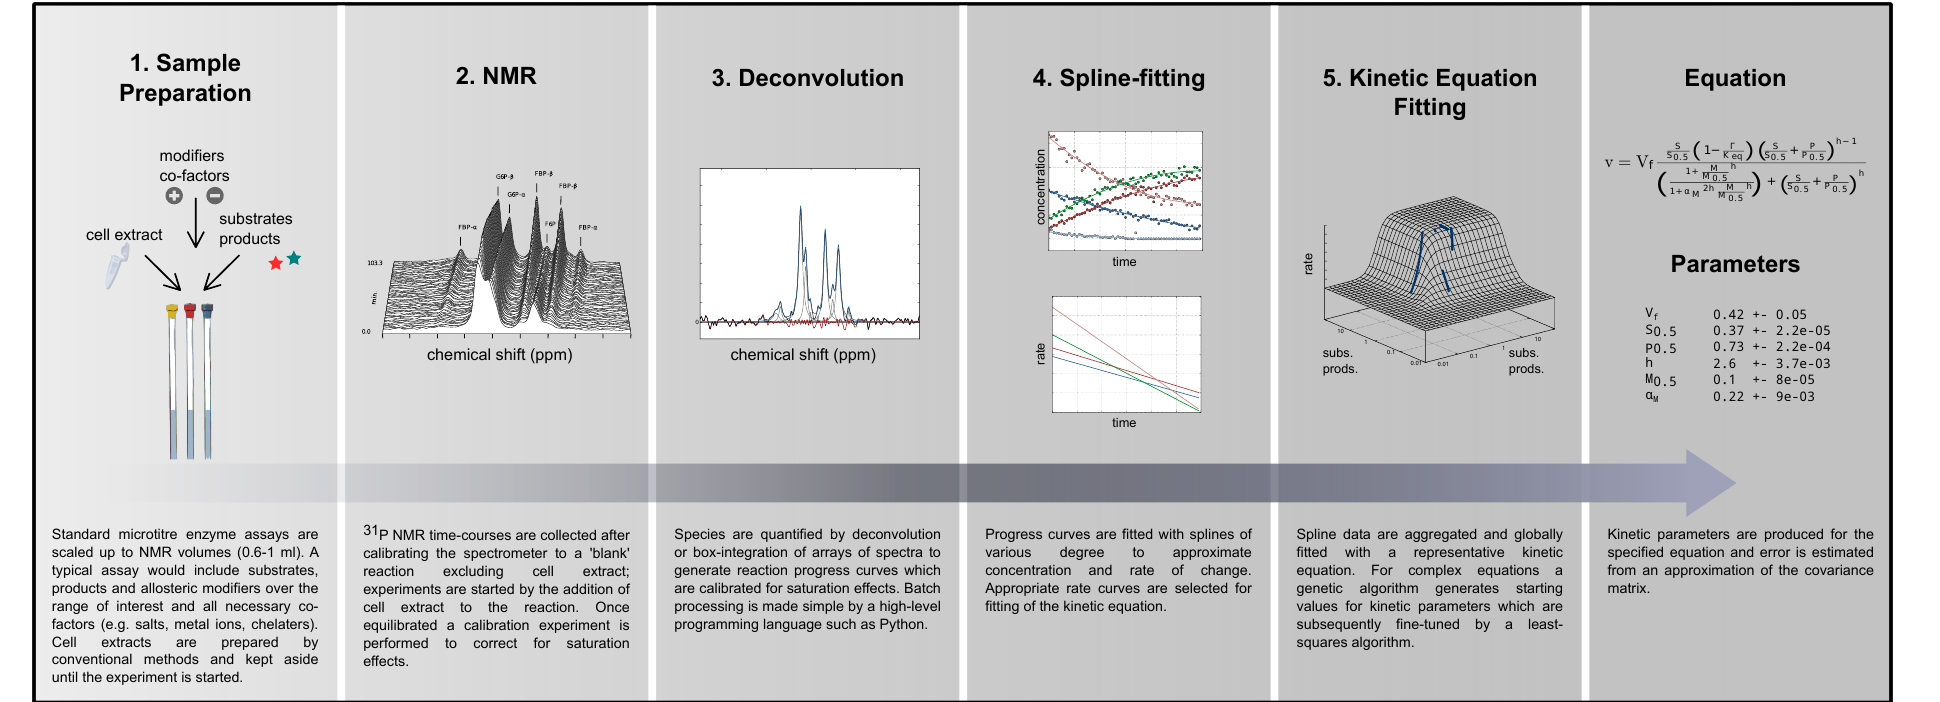
Figure 1. A work flow